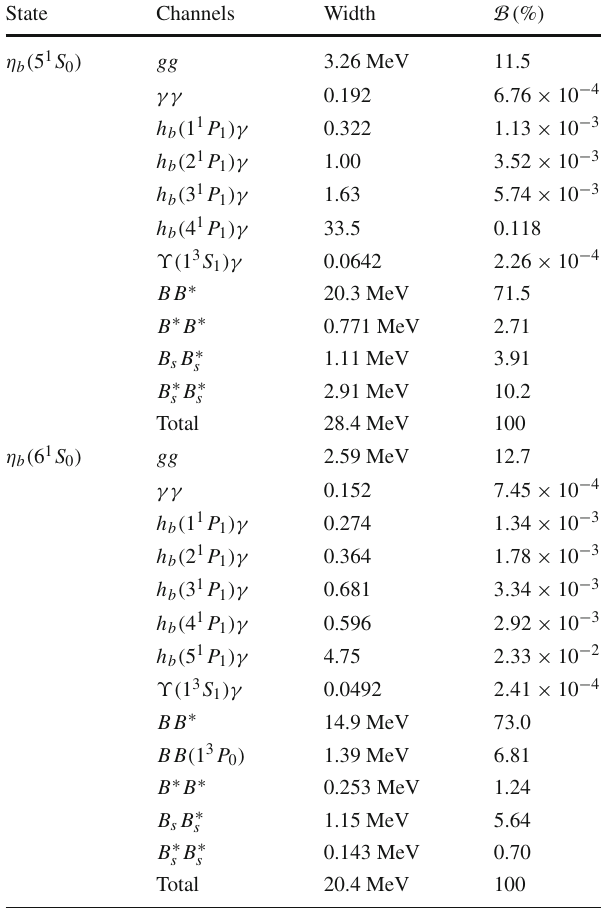
Table19 PartialwidthsandbranchingratiosoftheOZI-allowedstrong decay, annihilation decay, and radiative transition and the total widths for 5 1 S 0 and 6 1 S 0 bottomonium states. The width results are in units of